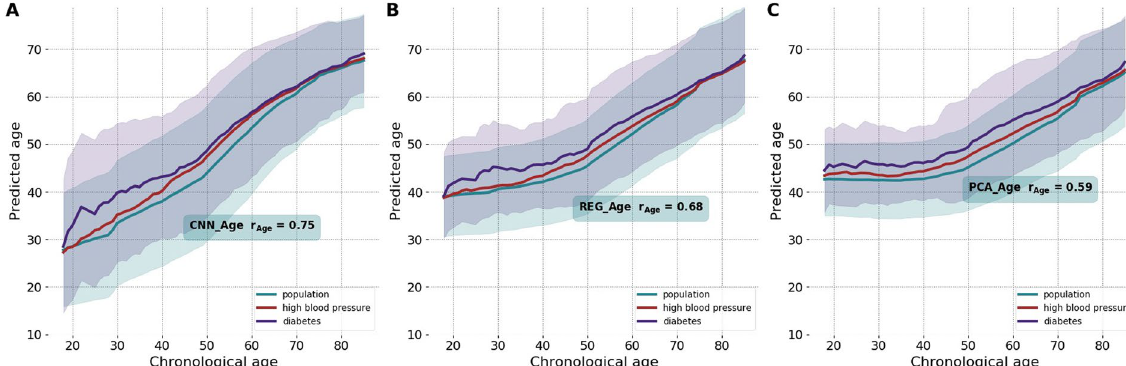
Figure 1. Accuracy of age-predicting models. The biological age estimation according to deep convolutional neural network CNN_Age ( A ), the multivariate regression REG_Age ( B ), and the unsupervised PCA_Age ( C ) models. The solid lines and the transparent ± standard deviation bands are color coded as green, blue, and red, representing the whole population, the patients diagnosed with diabetes by a doctor, and individuals with self- reported high blood pressure, respectively. All the calculations were produced using the NHANES 2003–2006 cohort wearable accelerometers data, comprising one-week long activity tracks (1 min − 1 sampling